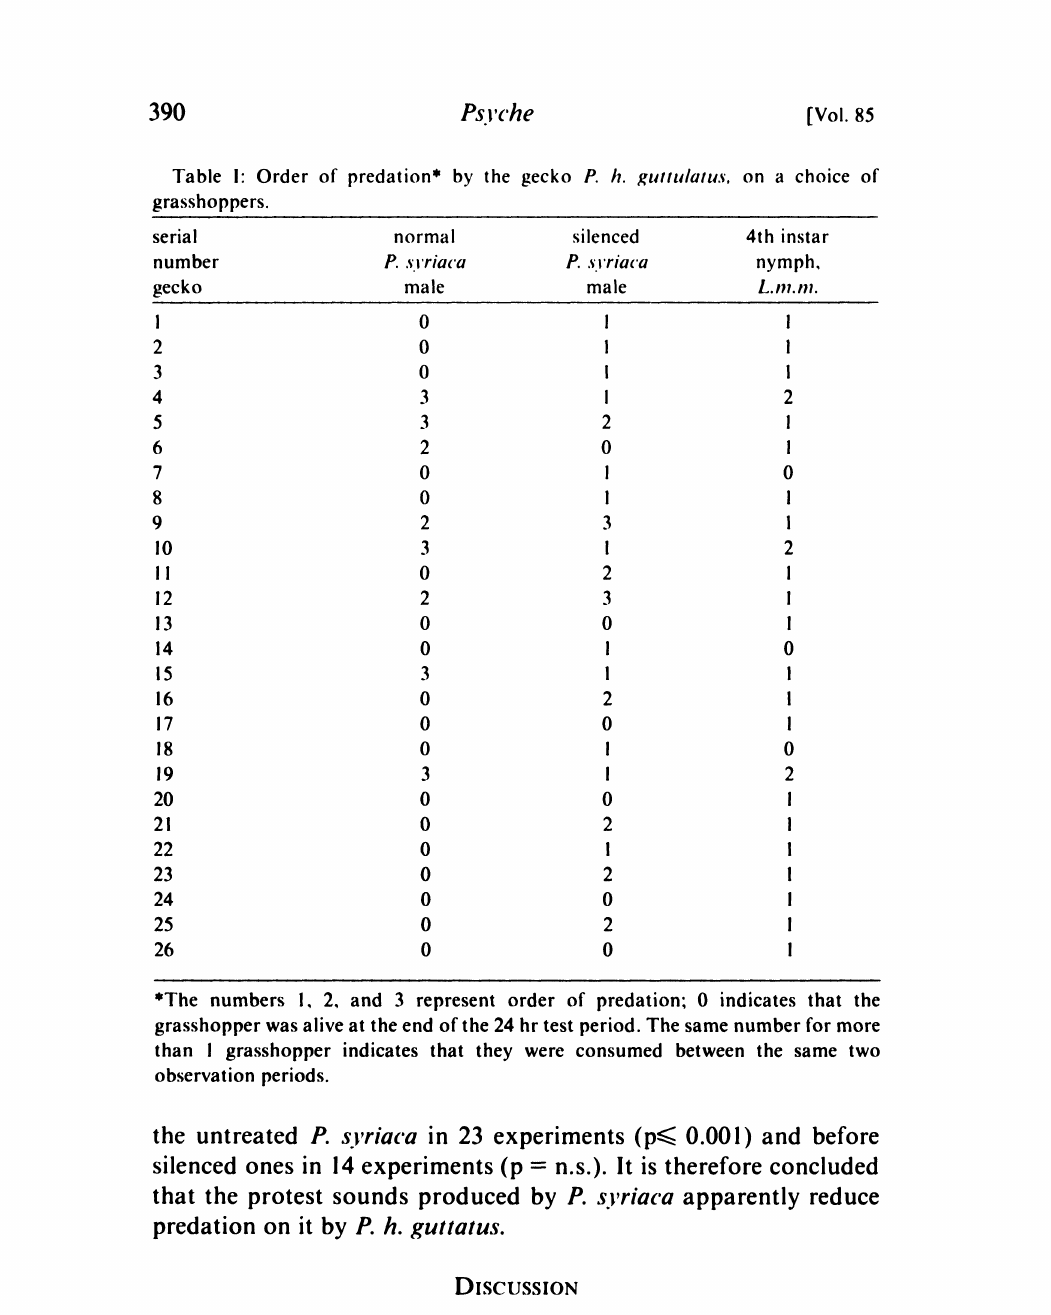
Table !: Order of predation* by the gecko P. h. guttulatus, on a choice of grasshoppers. serial normal silenced